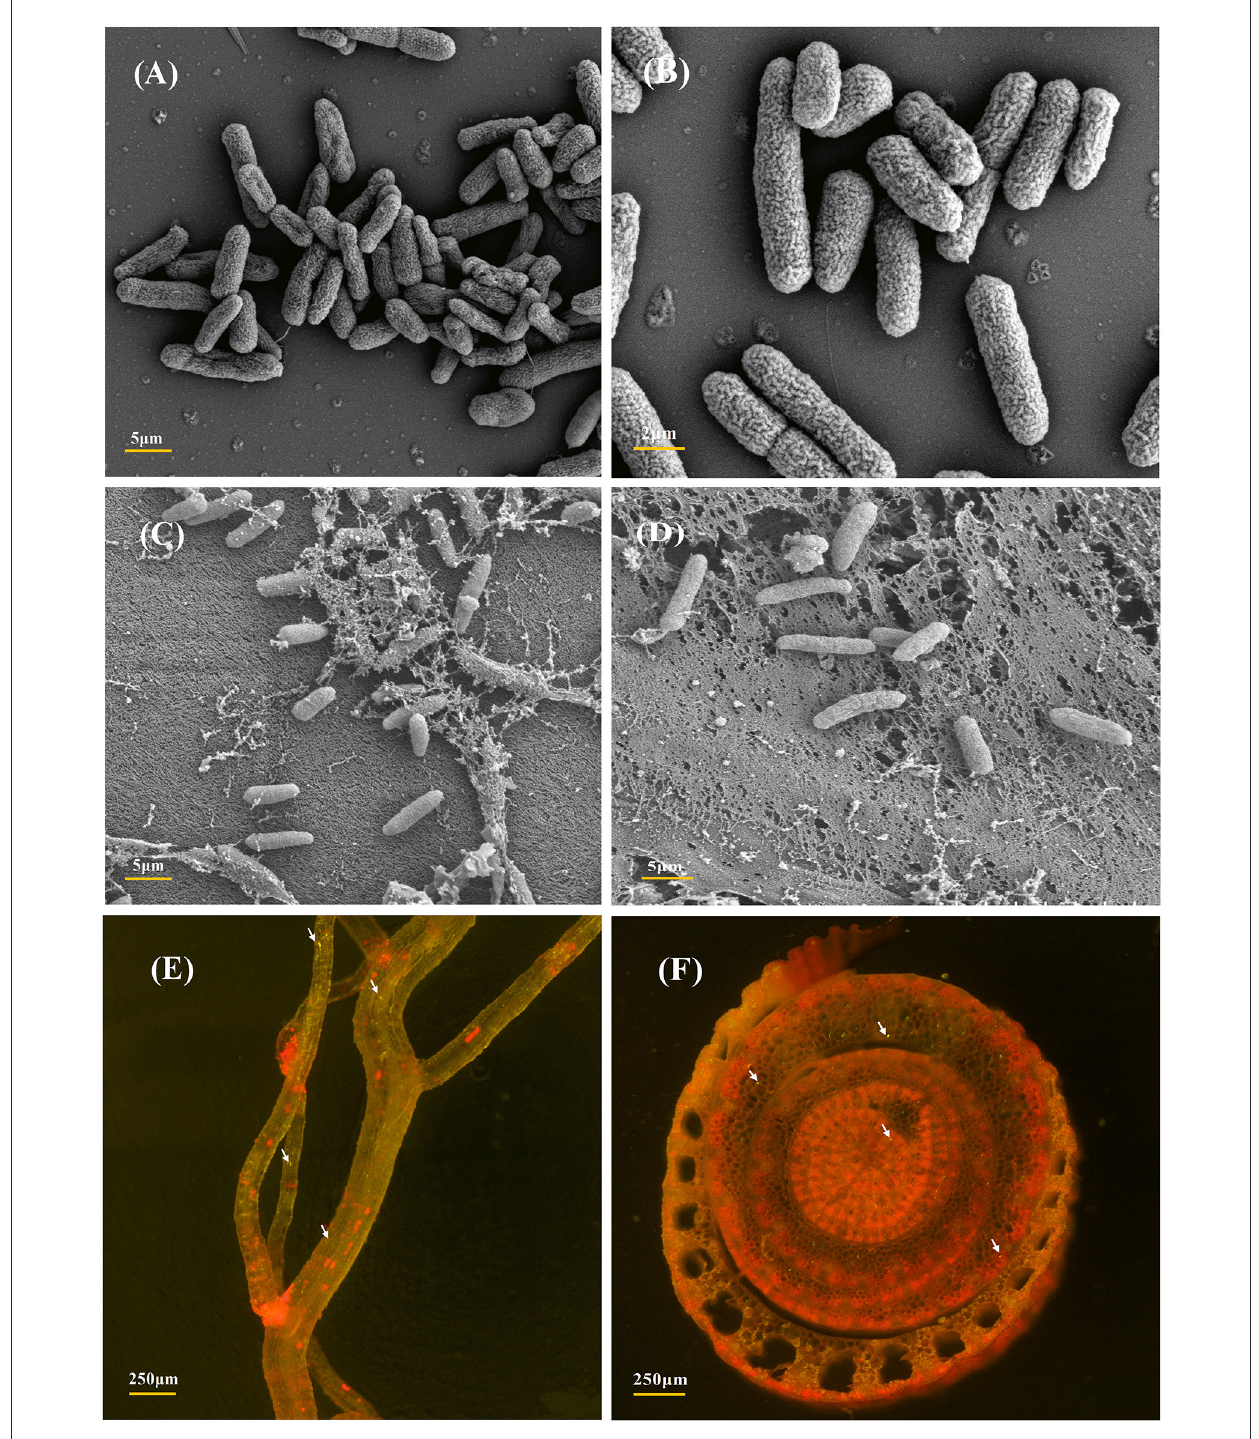
FIGURE1 SEM and CLSM micrographs of the most efficient endophytic Pseudomonas aeruginosa DJ06 strain and its colonization in sugarcane plant parts at the root and stem regions. (A, B) Are the SEM images showing the morphology of the DJ06 strain, (C, D) are the colonization images obtained after the inoculation of the DJ06 strain in sugarcane root and stem, (E, F) show the CLSM micrographs of GFP-tagged endophytic DJ06 strain in sugarcane root and stem. Green fluorescence within the root and stem tissues indicated by white arrows indicates that the DJ06 strain has colonized in the